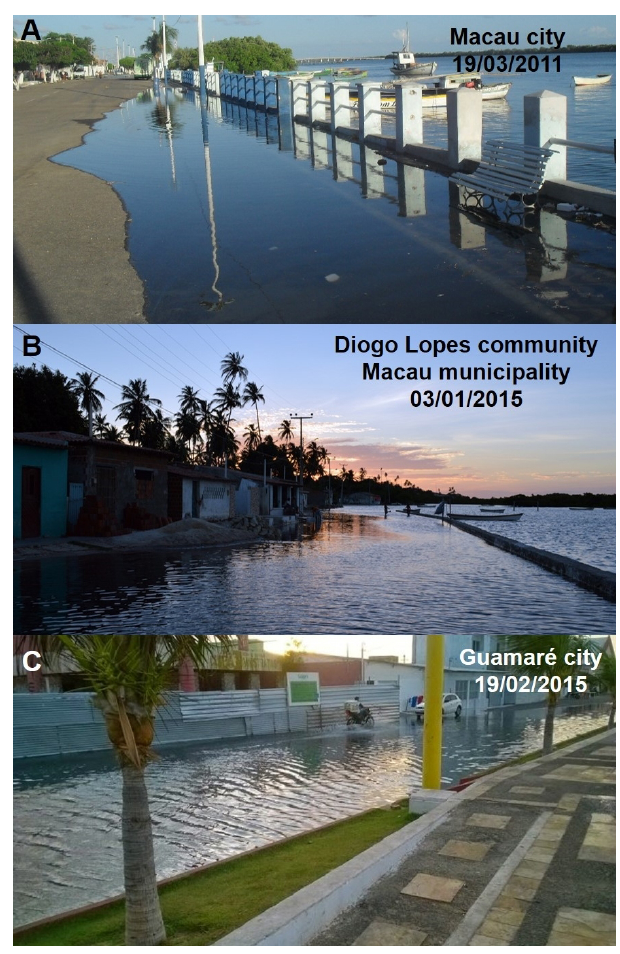
Figure 2. Tidal flooding events of the northern coast of Rio Grande do Norte state: (a) Macau urban area, Macau municipal- ity, 19 March 2011 (unknown author); (b) Diogo Lopes commu- nity, Macau municipality, 3 January 2015 (Tiago Ezequiel); and (c) Guamaré urban area, Guamaré municipality, 19 February 2015 (un- known